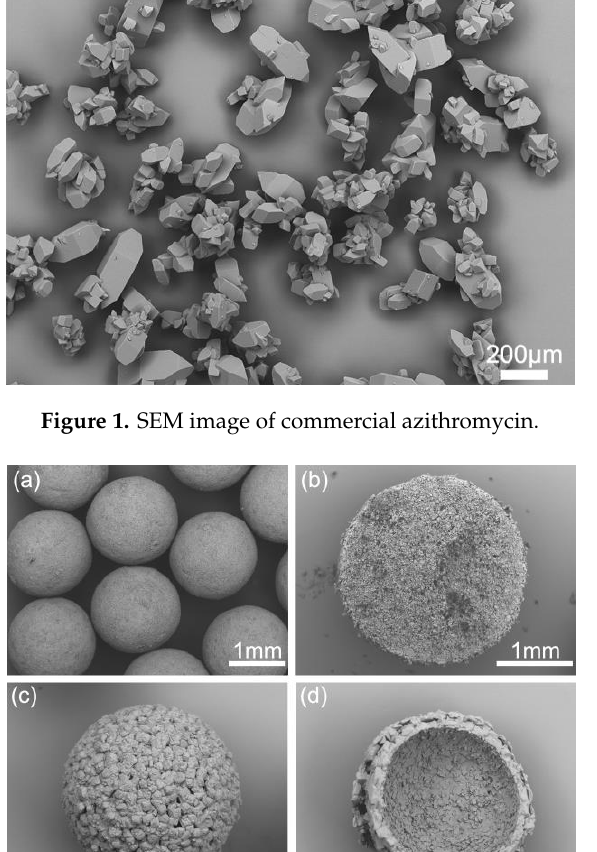
Figure 1. SEM image of commercial azithromycin.